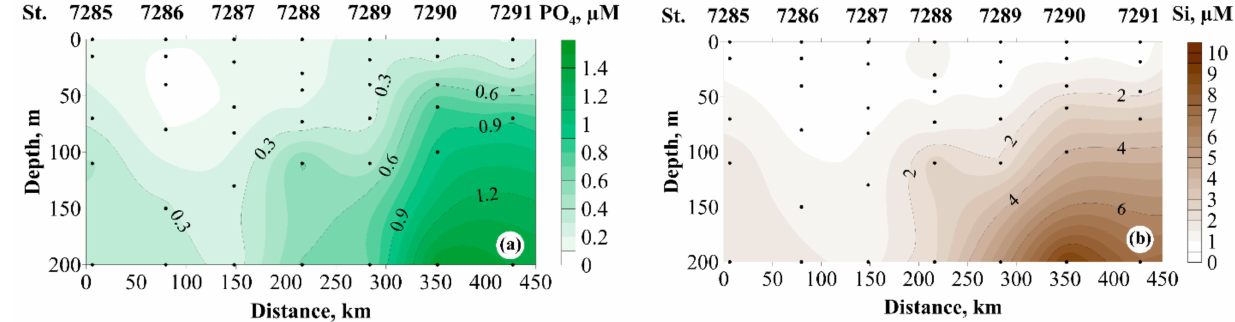
Figure 8. Distribution of dissolved phosphorus (PO 4 , µ M) ( a ) and silicates (Si, µ M) ( b ) over the section.